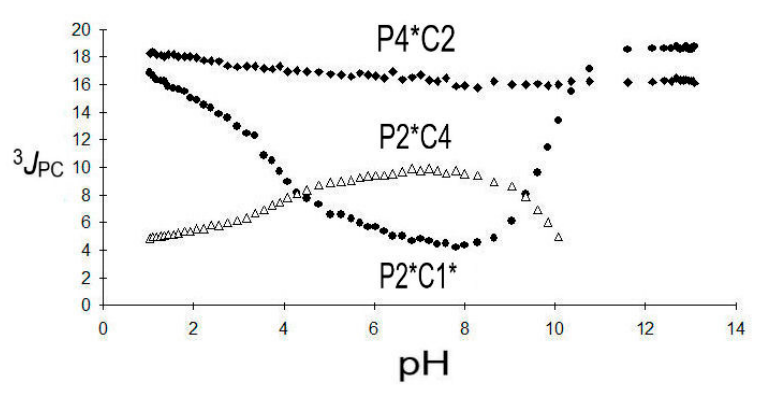
Figure 5. Three coupling constants 3 J PC (P2*C1*), 3 J PC (P2*C4), and 3 J PC (P4*C12) in DPBDC 9 .